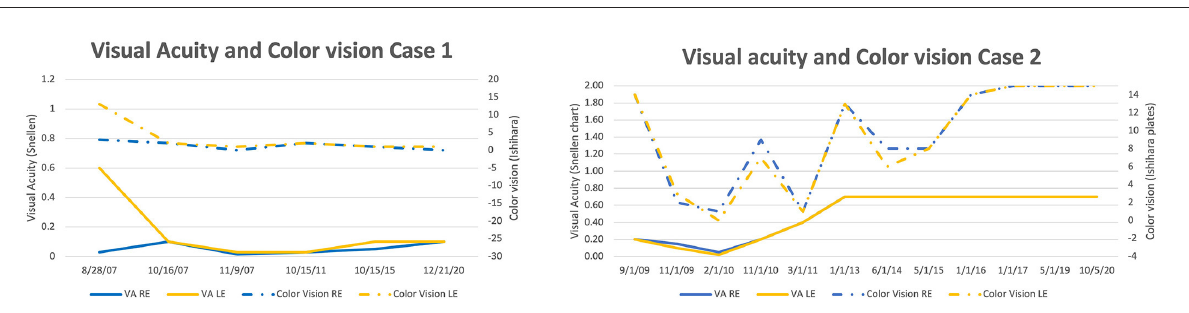
were retested and DNAJC30:c.152G > A pathogenic homozygous variant c.152A > G (p.Tyr51Cys) in DNAJC30:c.152G > A gene was